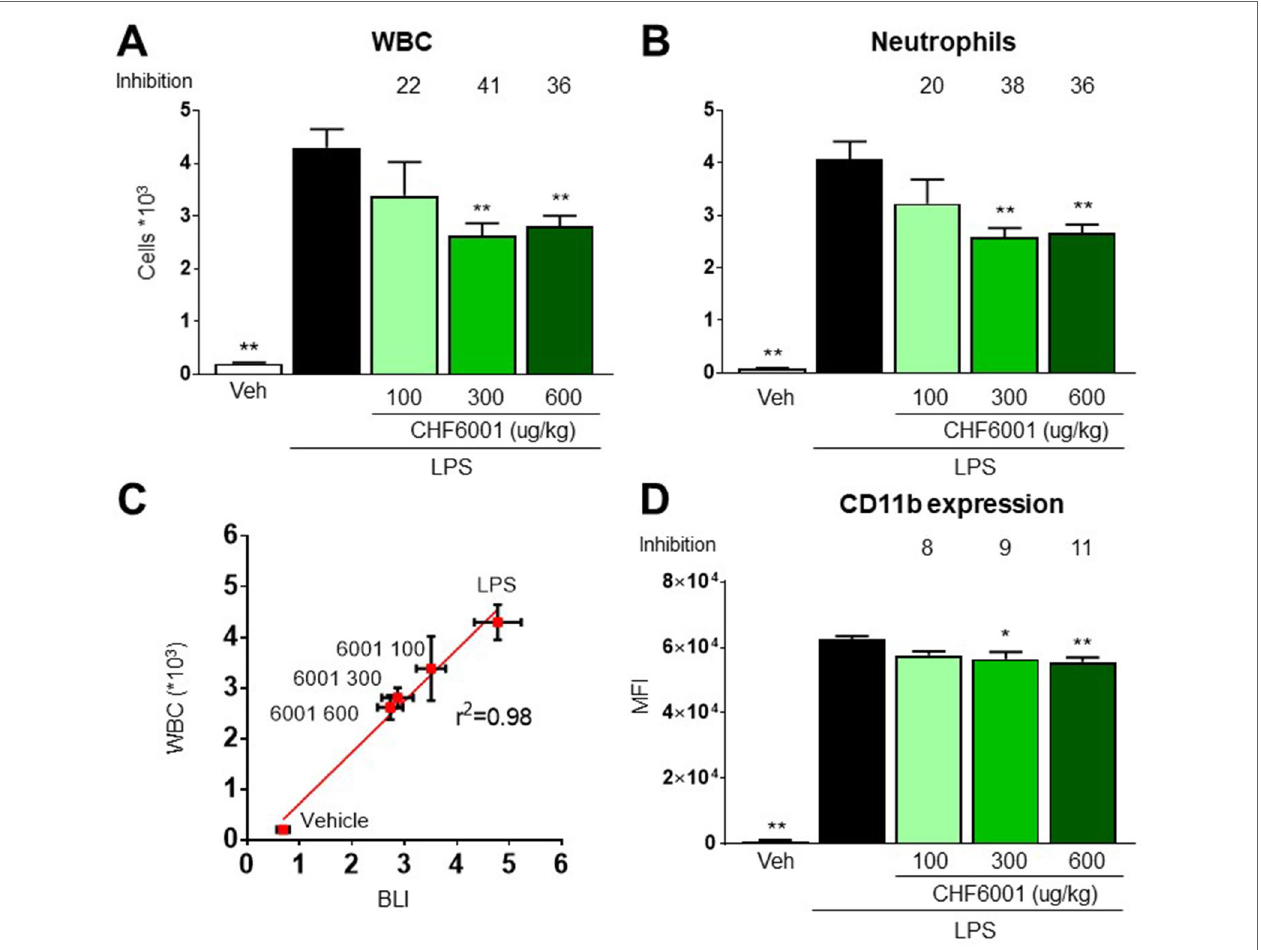
FIGURE 4 | Effects of CHF6001 on lipopolysaccharide (LPS)-induced neutrophils and white blood cell (WBC) recruitment and on monocyte/macrophages adhesion molecule expression. (A) and (B) Transient NF-kBluc transgenic mice were pretreated with saline or CHF6001 (100–600 µg/kg) 1 h before LPS and sacrificed 24 h after LPS administration by tracheal instillation. WBC (A) and neutrophils (B) were counted with an automated cell counter. (C) Correlation between NF-kB activation as measured by BLI, 4 h after LPS instillation, and the concentrations of WBC in bronchoalveolar lavage fluids, obtained 24 h after LPS instillation. (D) CD11b surface activation marker expression on monocytes/macrophages characterized as CD45 + F4/80 + GR1 − cells. Values are shown as the mean ± SEM, n = 6 for each group, and percent inhibition versus LPS group is reported. * P < 0.05, ** P < 0.01 versus LPS group (Dunnett’s test).